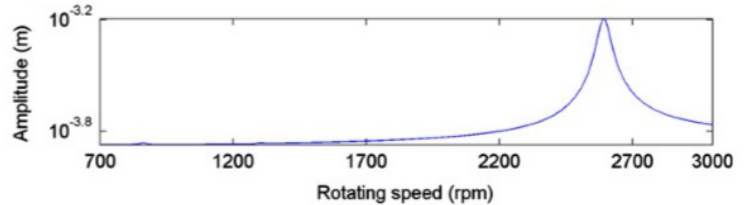
Figure 14. Amplitude of signal of the displacement at speed sweep for α = 0.01. Reprinted/adapted with permission from [45]. 2013. Elsevier.